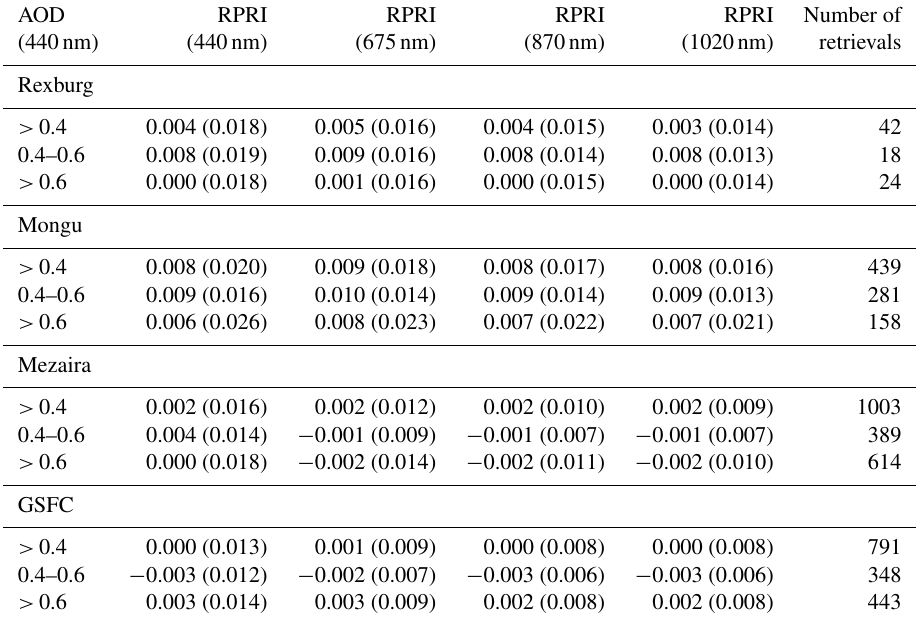
Table 2. Average values and standard deviations (in parentheses) of the difference in the real part of refractive index (RPRI) retrievals from inversions using STD and REL assumptions on IPRI smoothness constraints. The difference is defined as REL minus